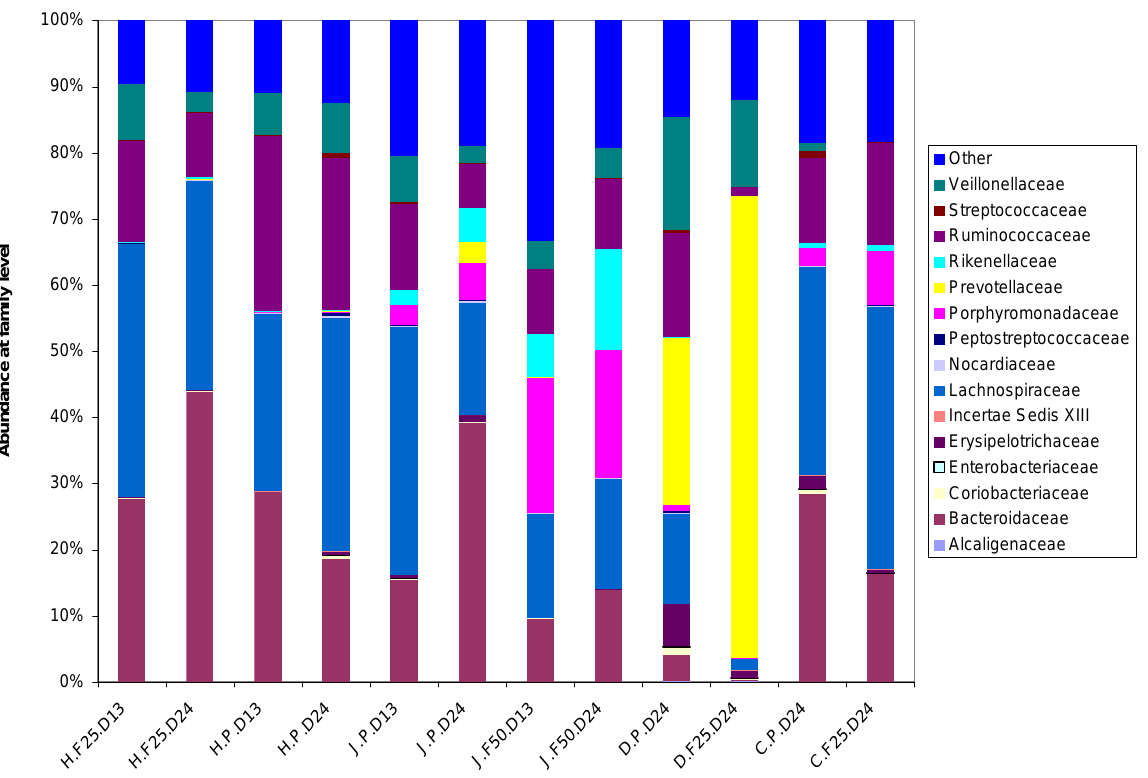
Figure 3. 454 sequencing for microbiota variation. 16s rRNA based abundance of dominant OTU’s on the family level. OTU’s grouping to each of the 15 most dominant OTU’s and all other OTU’s combined are color coded. 16S rRNA sequences were analyzed using the RDP pyrosequencing pipeline using standard settings for removal of low quality reads. Samples from subjects H, J, D, and C were analyzed during placebo(P), RM25 (F25) or RM50 (F50) on days 13 (D13) and Day 24(D24). Each column shows the bacterial composition of one fecal sample based on Megablast searches against the Greengenes database. Except for samples H.F25.D24 (H 25 in Figure 2) and H.P. D24 (H 0 in Figue 2) samples differ from those shown in Figure